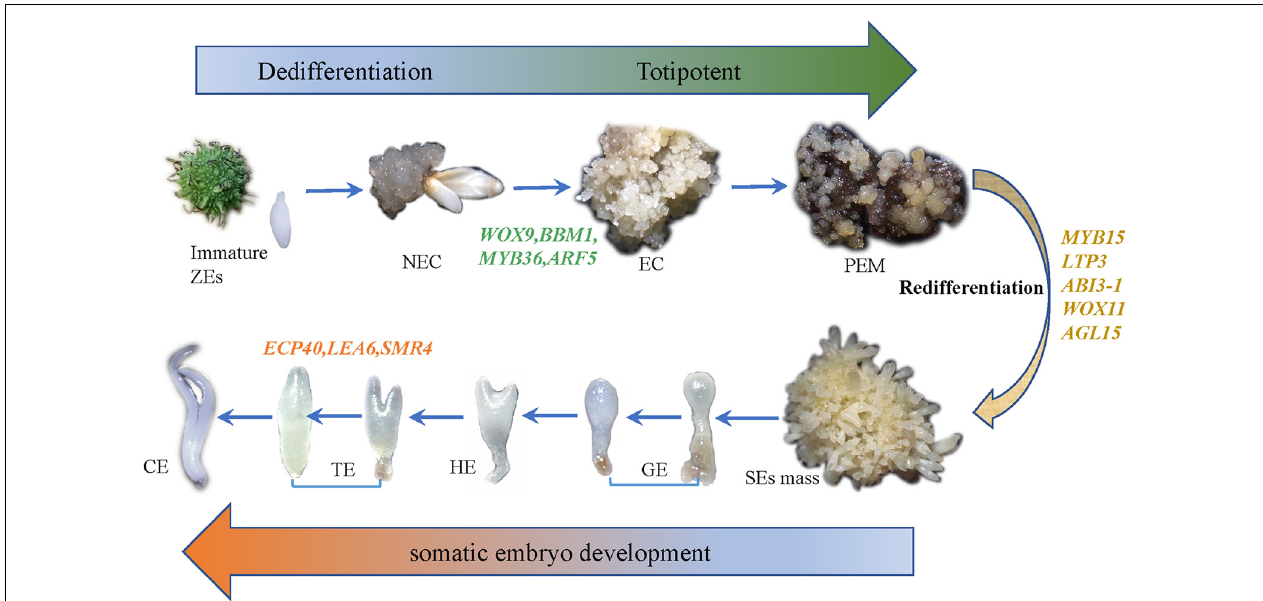
FIGURE 2 | The whole experimental diagram and hypothesized molecular mechanisms of SE.